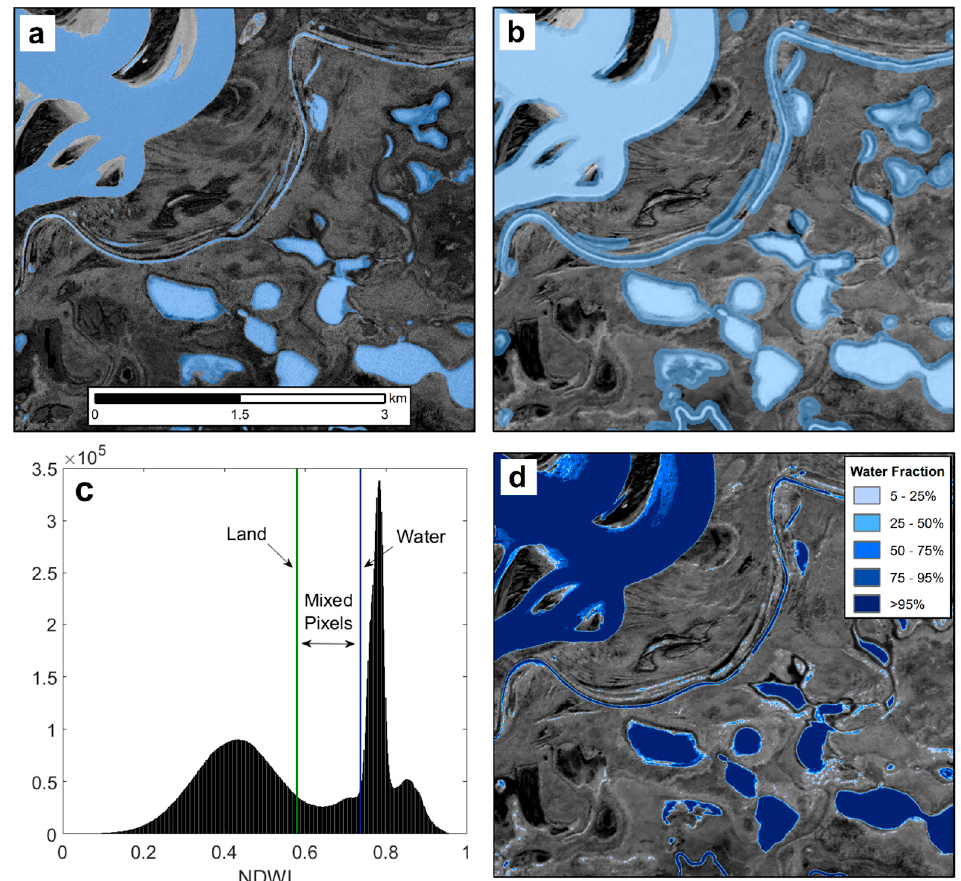
Figure 3. Demonstration of classification method: ( a ) the initial adaptive OTSU classification; ( b ) the buffered maximum lake polygons; ( c ) the histogram classification from the buffered lake polygons with land level ( LL ) and water level ( WL ) labeled; ( d ) the final water fraction map generated by applying the land and water levels to the NDWI image.